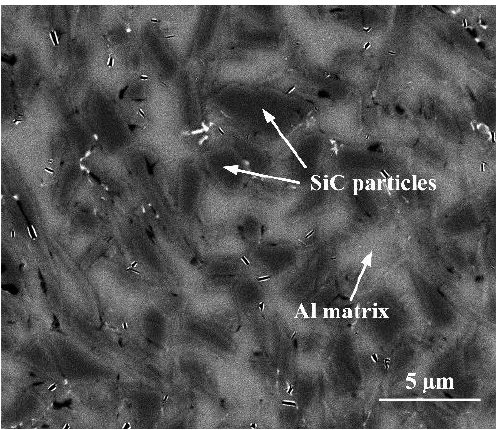
Figure 1. Microstructure of the SiCp/Al composites.